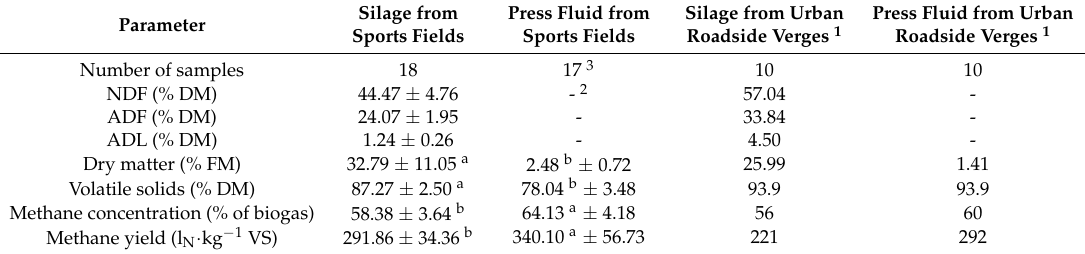
Table 2. Anaerobic digestion related properties of grass from urban proveniences. Standard deviations are given. Silage from Press Fluid from Silage from Urban Parameter Sports Fields Sports Fields Roadside Verges